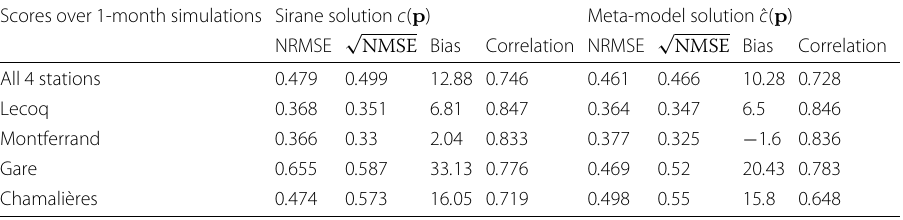
Fig. 11 Mean NO 2 concentrations µ gm − 3 at 5 sensor locations over weekdays in November 2014. Curves show observations, full model simulations, projected simulations onto the reduced basis, and emulated solutions Table 5 Statistical scores of the meta-model approximation results compared to observation data Scores over 1-month simulations Sirane solution c ( p